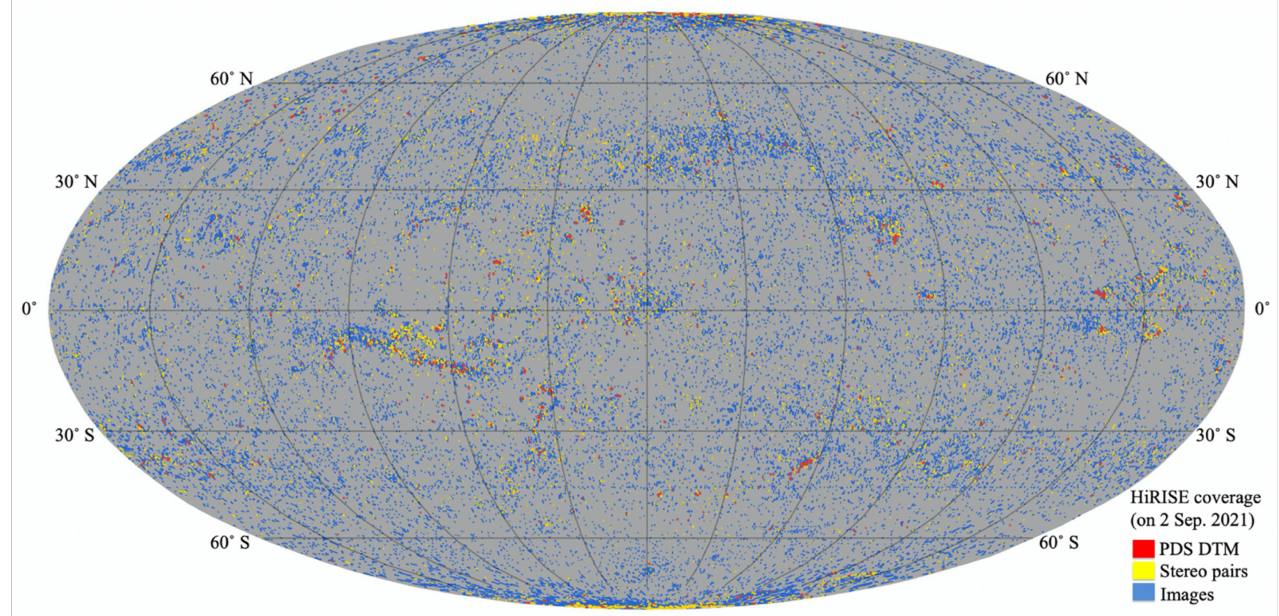
Figure 1. Global coverage of HiRISE images, targeted stereo pairs, and existing PDS DTMs released on 2 September